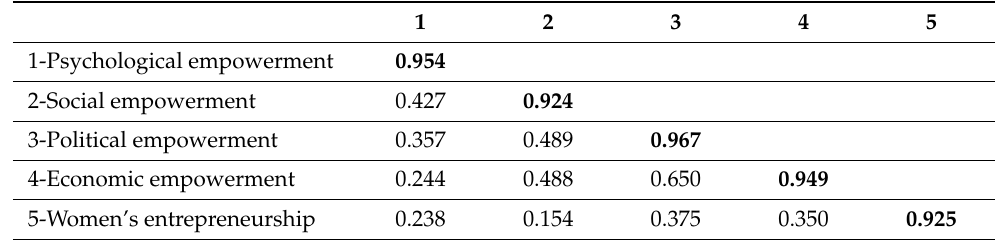
Table 2. Fornell–Larcker criterion analysis.